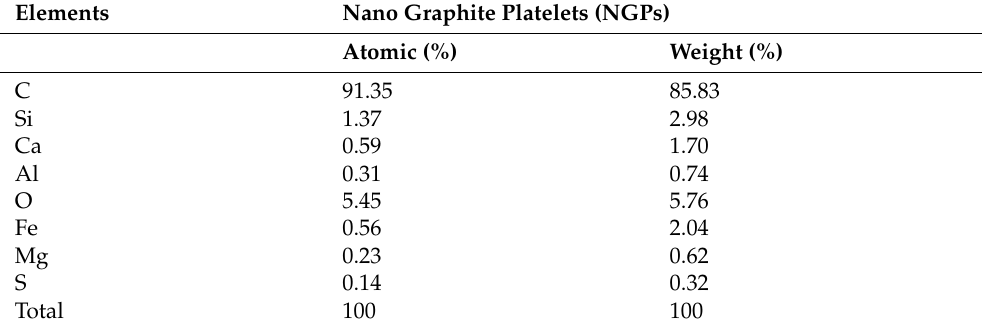
Table 6. Chemical composition of